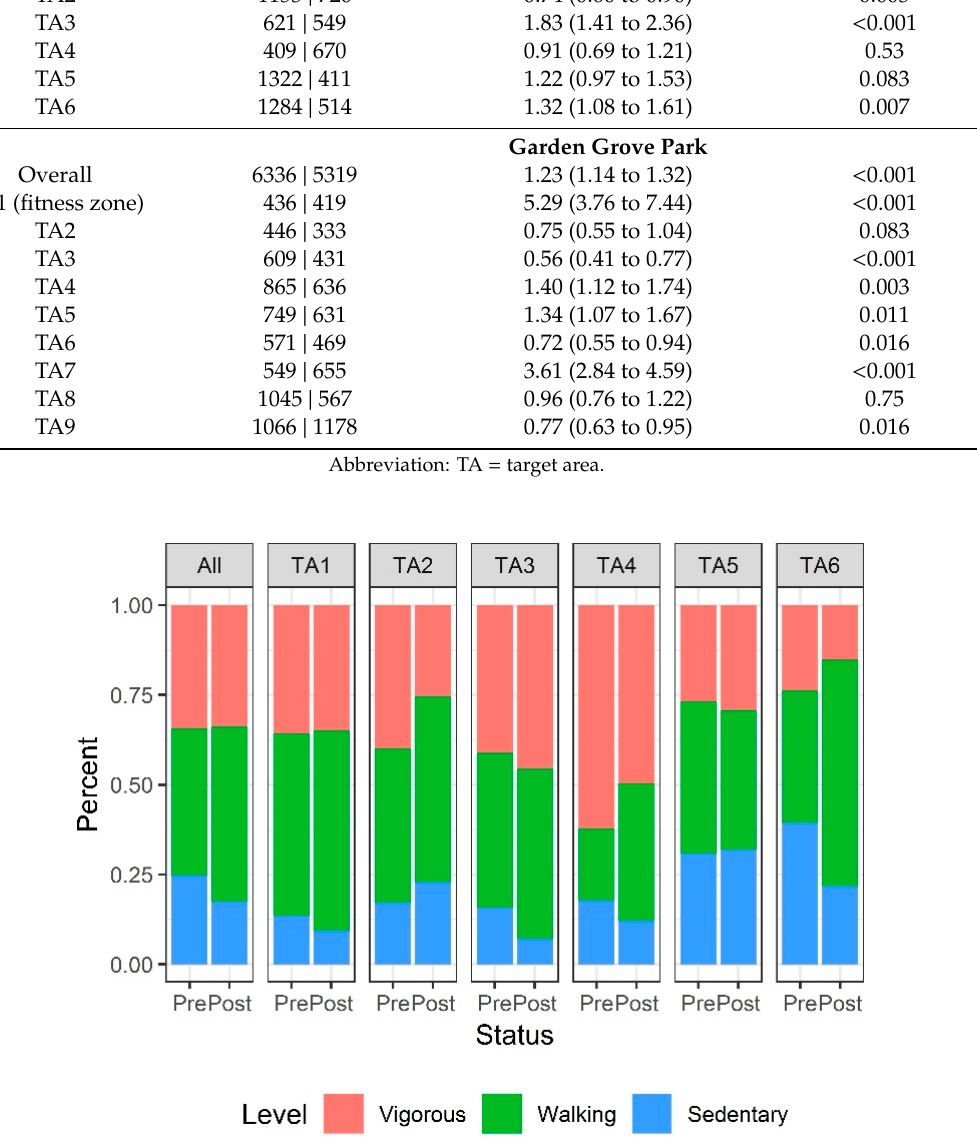
Figure 2. Distribution of physical activity levels in Edison Park pre- and post-intervention. The numbers of observed person-periods pre-intervention and post-intervention overall and within each TA is listed in Table 2.